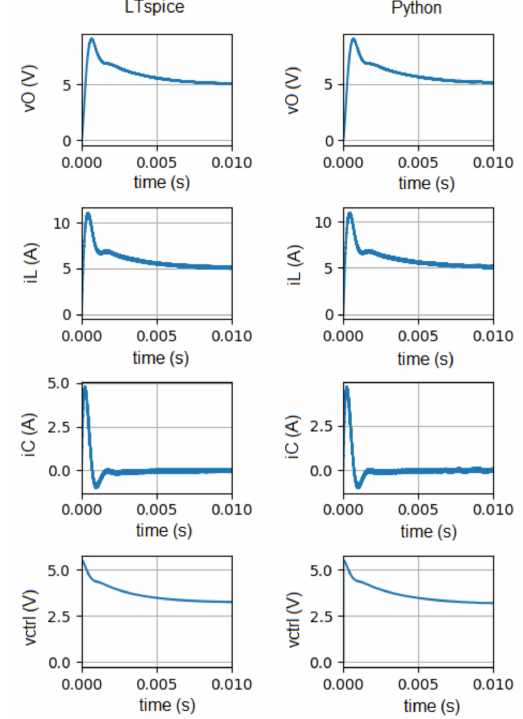
Figure 12. Waveforms of v O , i L , i C and v ctrl obtained during the converter start up, with LTspice ( left plots ) and with the proposed simulation technique ( right plots ).